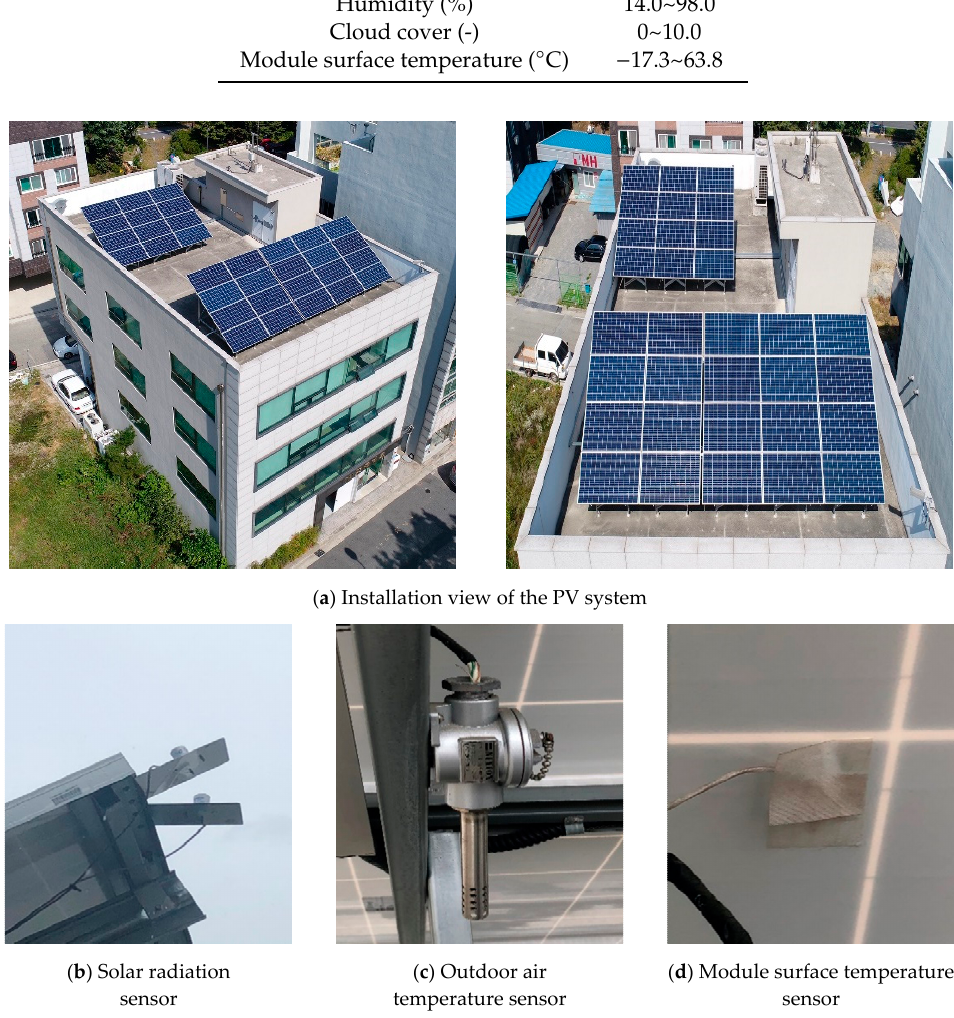
Figure 1. Photos for the photovoltaic system and sensors. Table 3. Electrical characteristics of the photovoltaic (PV) system (PV module name: SN310P-23